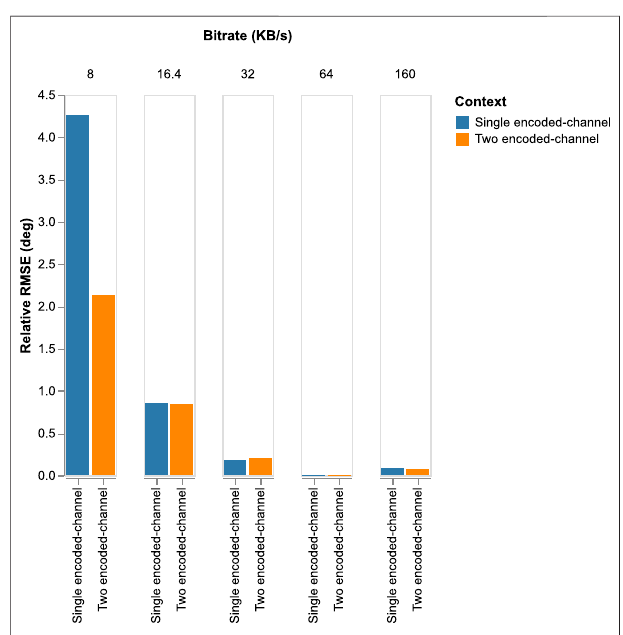
FIGURE 15 | Relative RMSE degradation for a varying bitrate performed for the two models: 1) Single encoded-channel model where one of the channels is without compression and the second is encoded with PyAWNeS. 2) The two encoded-channel model where the two inputs are encoded similarly with PyAWNeS at a varying